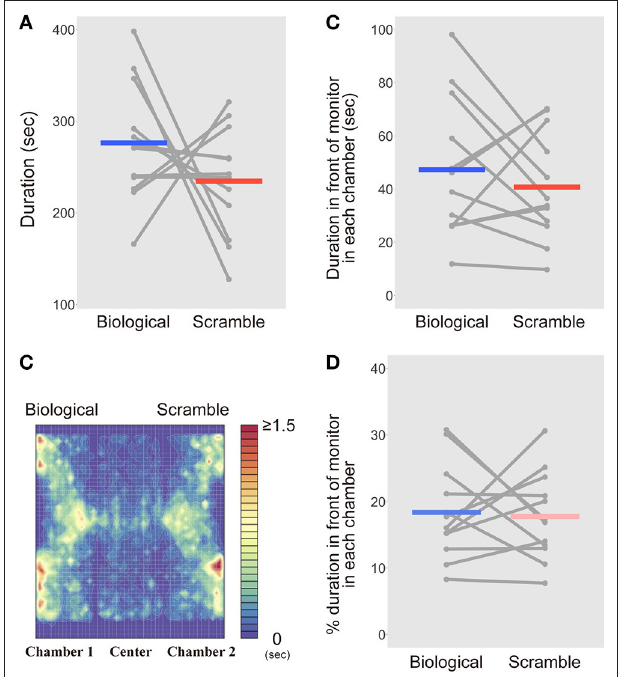
then evaluated the amount of attention mice paid to the